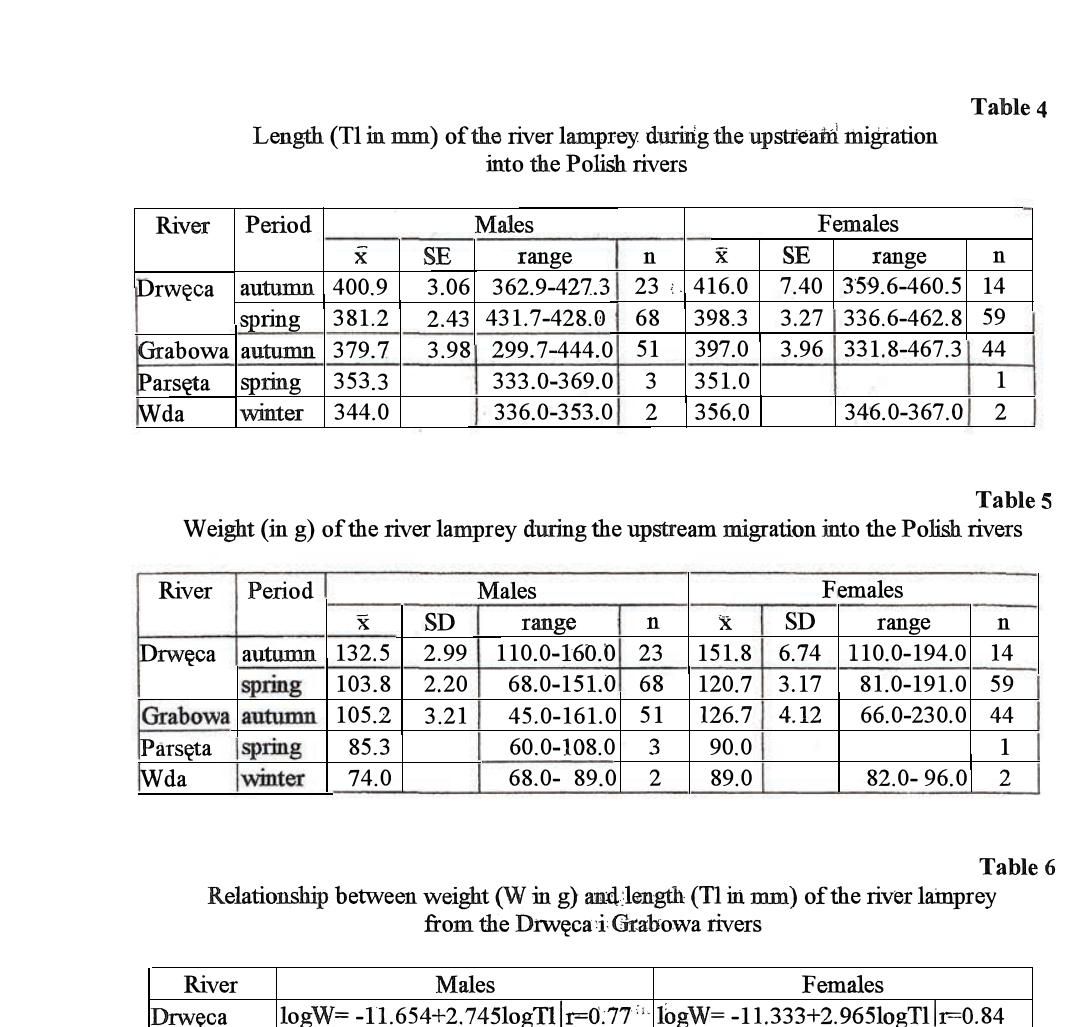
Relationship between weight (TI in mm) of the river lamprey